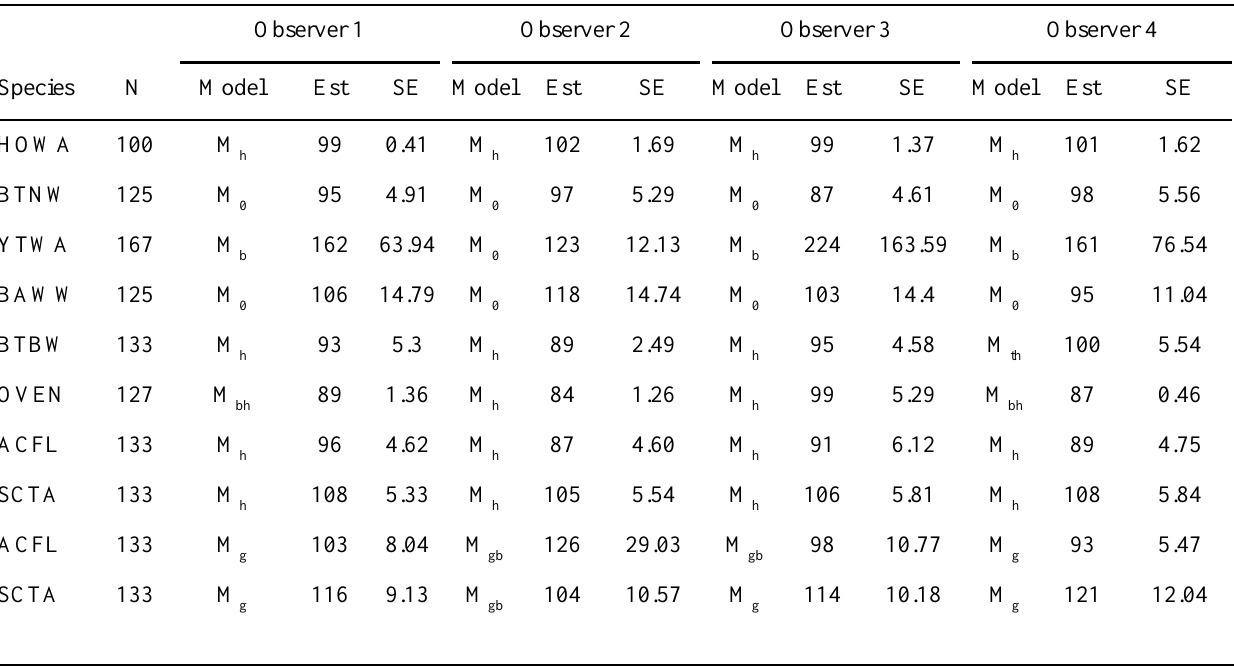
Table 2. Top models chosen using AICc and estimated population sizes and standard errors for four experienced observers. Singing rates of the first four species were homogeneous (all birds had the same probability of calling in each interval). The next four species were heterogeneous. ACFL and SCTA are presented first when groups are modeled with unidentifiable heterogeneity (h) and second when modeled with identifiable heterogeneity (g). All species except the BAWW had a high homogeneous singing rate per